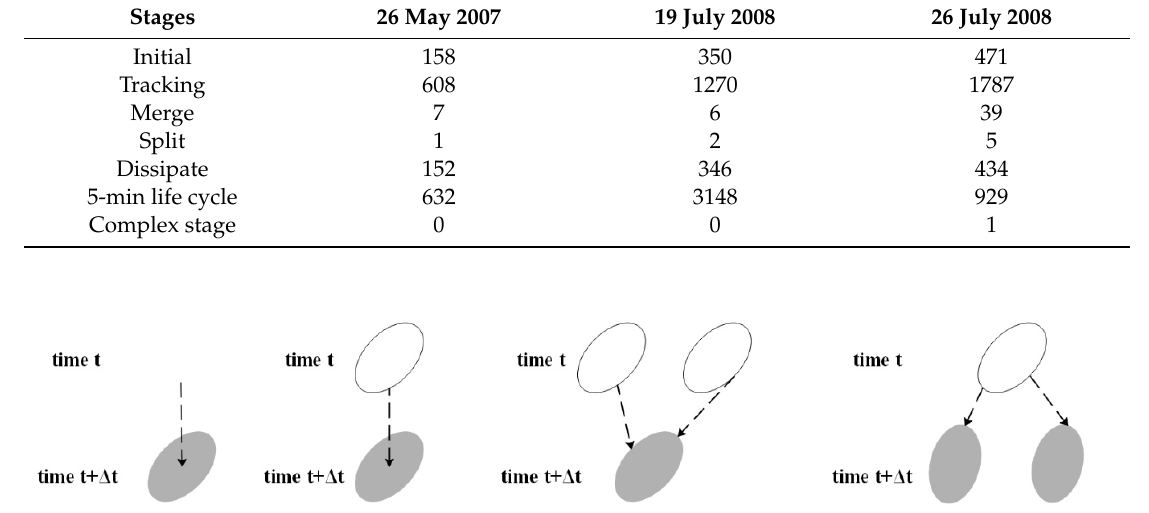
Table 3. Number of rain cells with di ff erent life stages, sorted by selected rain day.